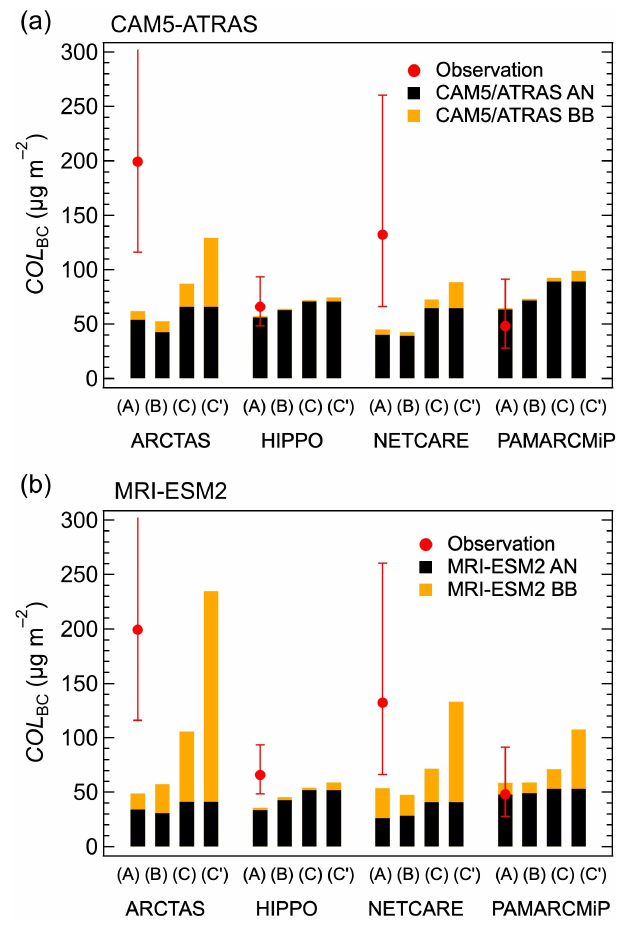
Figure 5. Observed column amounts of BC mass concentration at altitudes between 0 and 5km and latitudes > 66 . 5 ◦ N (COL BC , red circles) and model-calculated COL BC values (vertical bars). For calculated values, contributions from anthropogenic (AN) and biomass burning (BB) emissions are shown by red and green col- ors, respectively. The model-calculated COL BC values were derived in three different ways by calculating median or average values for individual altitude ranges: (A) median values along the flight tracks, (B) area-weighted averages within the areas and time peri- ods of the individual aircraft-based experiments shown in Table 3, and (C) area-weighted averages within the entire region at latitudes north of 66.5 ◦ N for the time periods of the individual aircraft ex- periments. (C (cid:48) ) is the same as (C) but with the calculated BB contri- butions multiplied by a factor of 3. (a) CAM5-ATRAS model sim- ulations. (b) MRI-ESM2 model simulations.